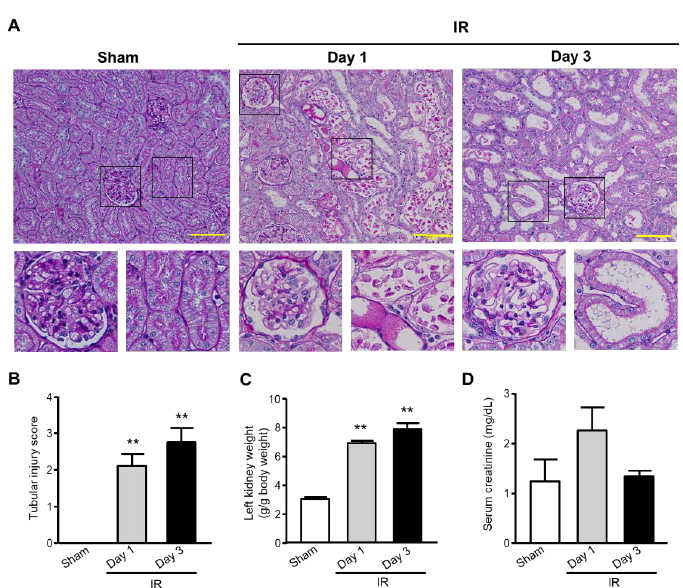
Figure 1. Kidney injury was determined by ischemia reperfusion in rats with unilateral nephrec- tomy. ( A ) Representative photomicrographs of the renal cortical regions stained by periodic acid– Schiff (PAS) reagent. Lower panels are enlarged images of upper panels (left, glomeruli; right, tubules). ( B ) Renal tubular injury (dilatation) was assessed using a semiquantitative score from 0 to 4: 0 = normal; 1 = mild; 2 = moderate; 3 = severe; and 4 = very severe. ( C , D ) Left kidney weight ( C ) and serum creatinine ( D ) were assessed. Sham-operated rats, n = 6; I/R-treated rats, n = 5. ** p < 0.01 vs. sham-operated rats. Scale bar, 100 µ m.